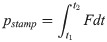
The low-pass filtered force signal of a stamp.The impulse of the foot stamp is equal to the shaded area under the curve pstamp=∫t1t2Fdt, with t1 10 ms before the threshold (2 N) is passed and t2 100 ms after the threshold crossing.